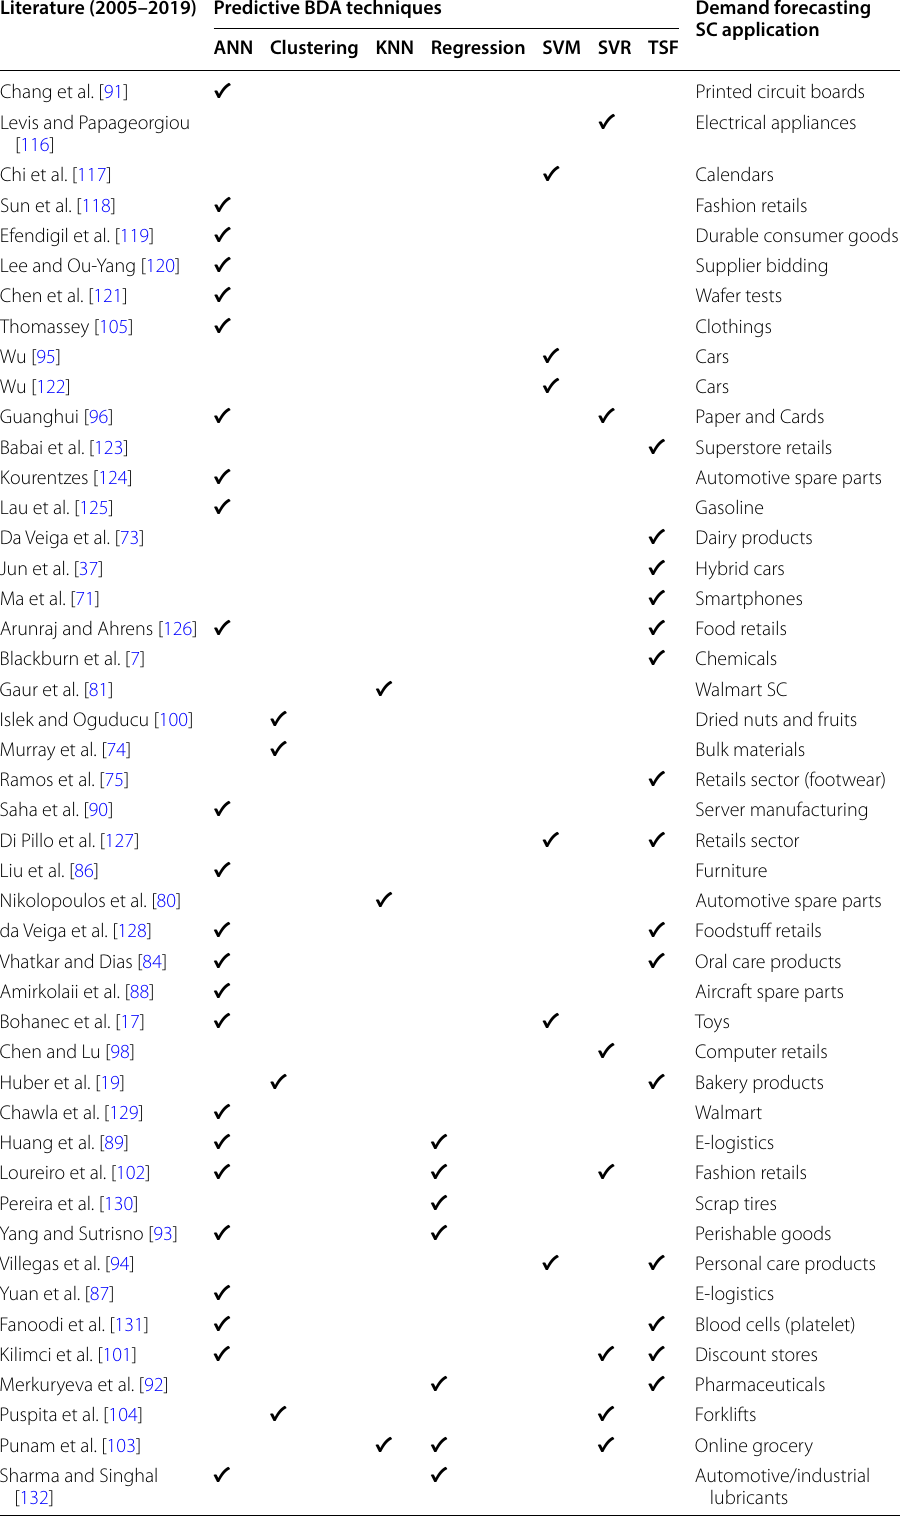
Table 3 Literature on applications of predictive BDA in SC demand forecasting (2005 to